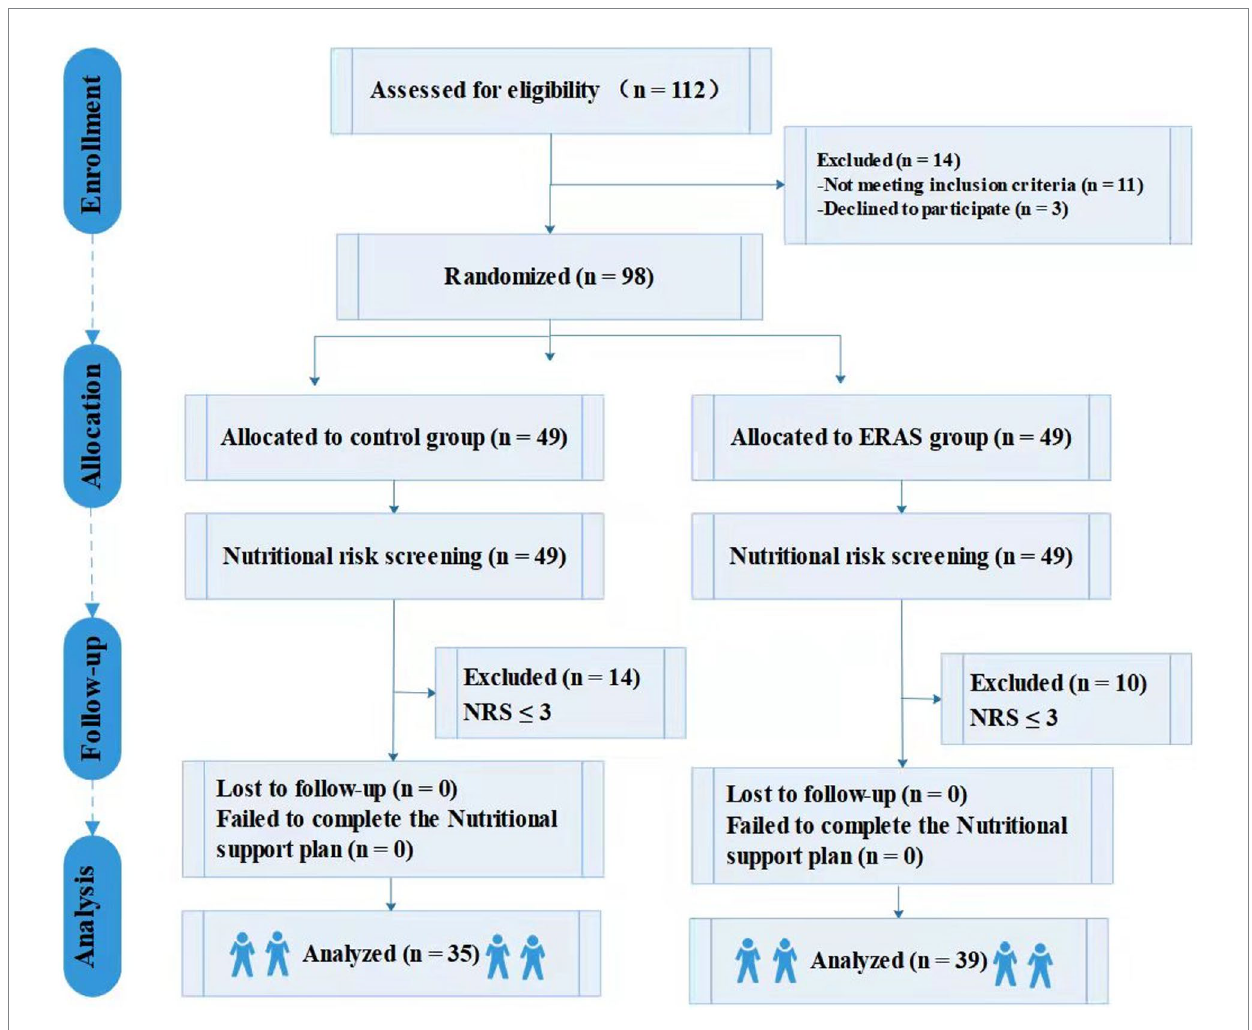
FIGURE 2 Flow diagram for study